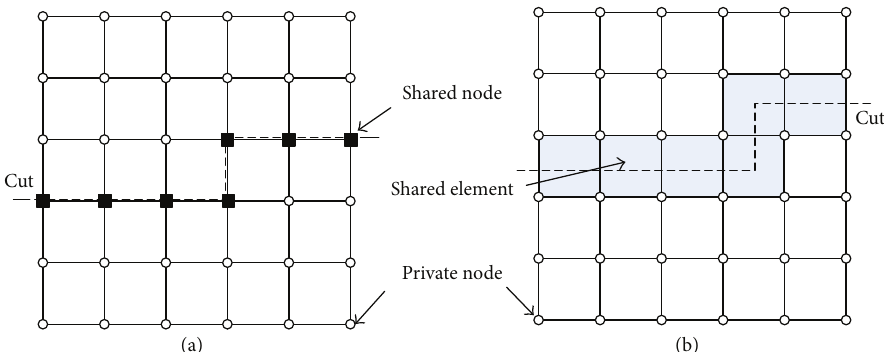
Figure 6: Partitioning method: (a) node-cut partitioning; (b) element-cut partitioning.